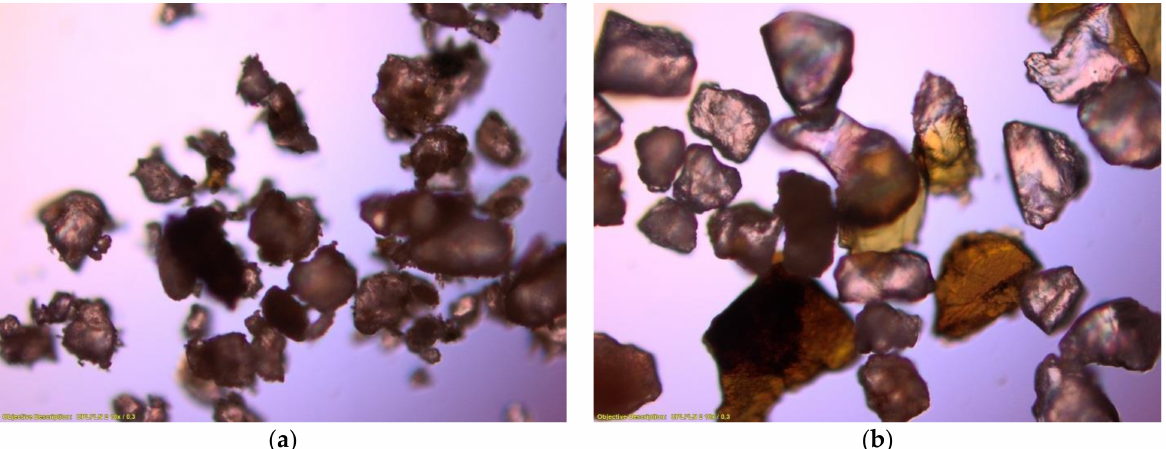
Figure 3. Optical micrographs ( × 100) of the dry soil ( a ) and the soil washed with water ( b